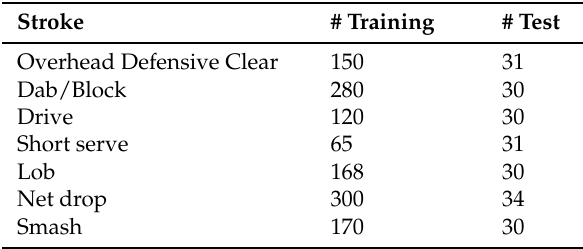
Table 3. Number of strokes in training and test data.